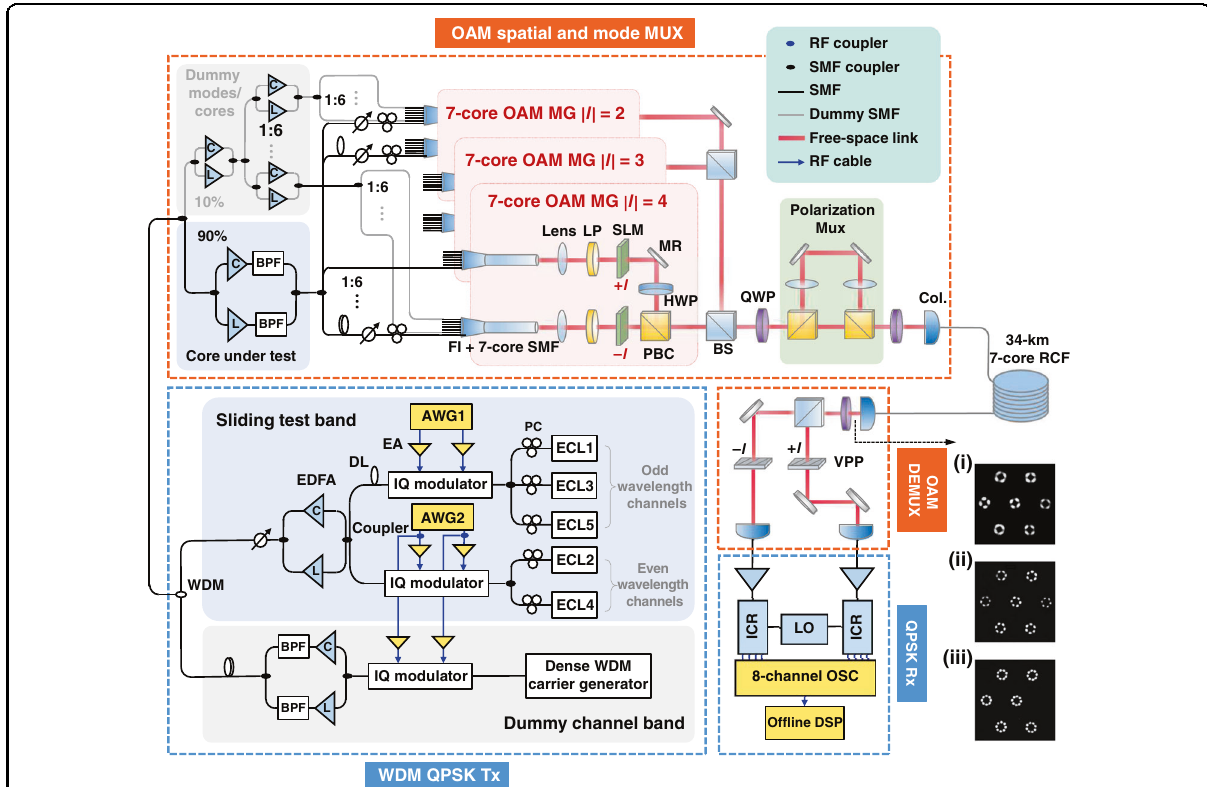
Fig. 3 The experimental setup for OAM-SDM-WDM data transmission. The intensity pro fi les of OAM MGs | l | = (i) 2, (ii) 3, and (iii) 4. A linear polarization (LP)-mode-like intensity pro fi le in each fi bre core is observed due to the coherent superposition of the four intra-MG OAM modes 17 . ECL external cavity laser; BPF band-pass fi lter; OP optical processor; FI Fan-in device; EDFA erbium-doped fi bre ampli fi er; LP linear polarizer; SLM spatial light modulator; MR mirror; HWP half-wave plate; Col. collimator; VPP vortex phase plate; ICR integrated coherent receiver; OSC oscilloscope; LO local oscillator; RF radio frequency; DSP digital signal